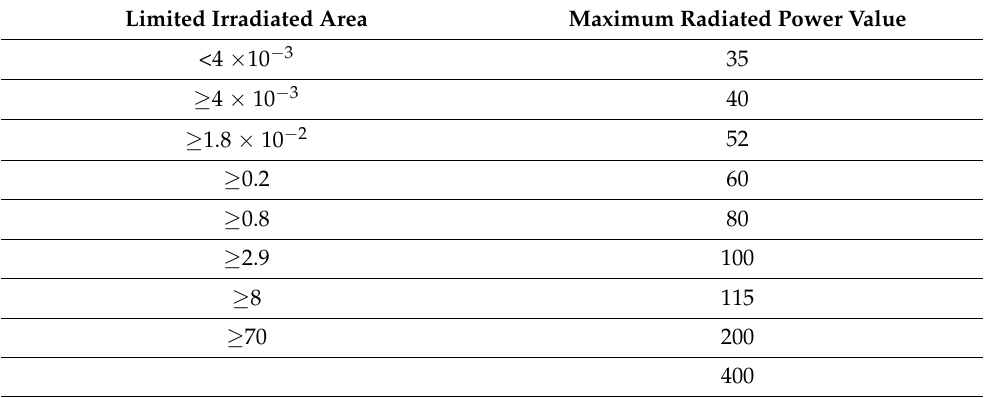
Table 2. Safe limit values for intermediate area, Group I or II, constant power, T1–T4 atmospheres, equipment Groups IIA, IIB or IIC